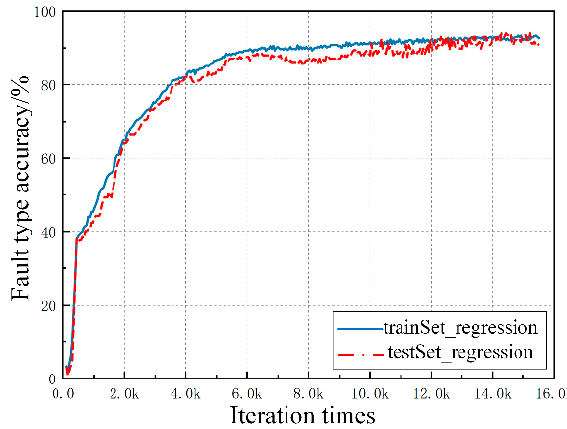
Figure 9. Prediction chart for fault type classification.